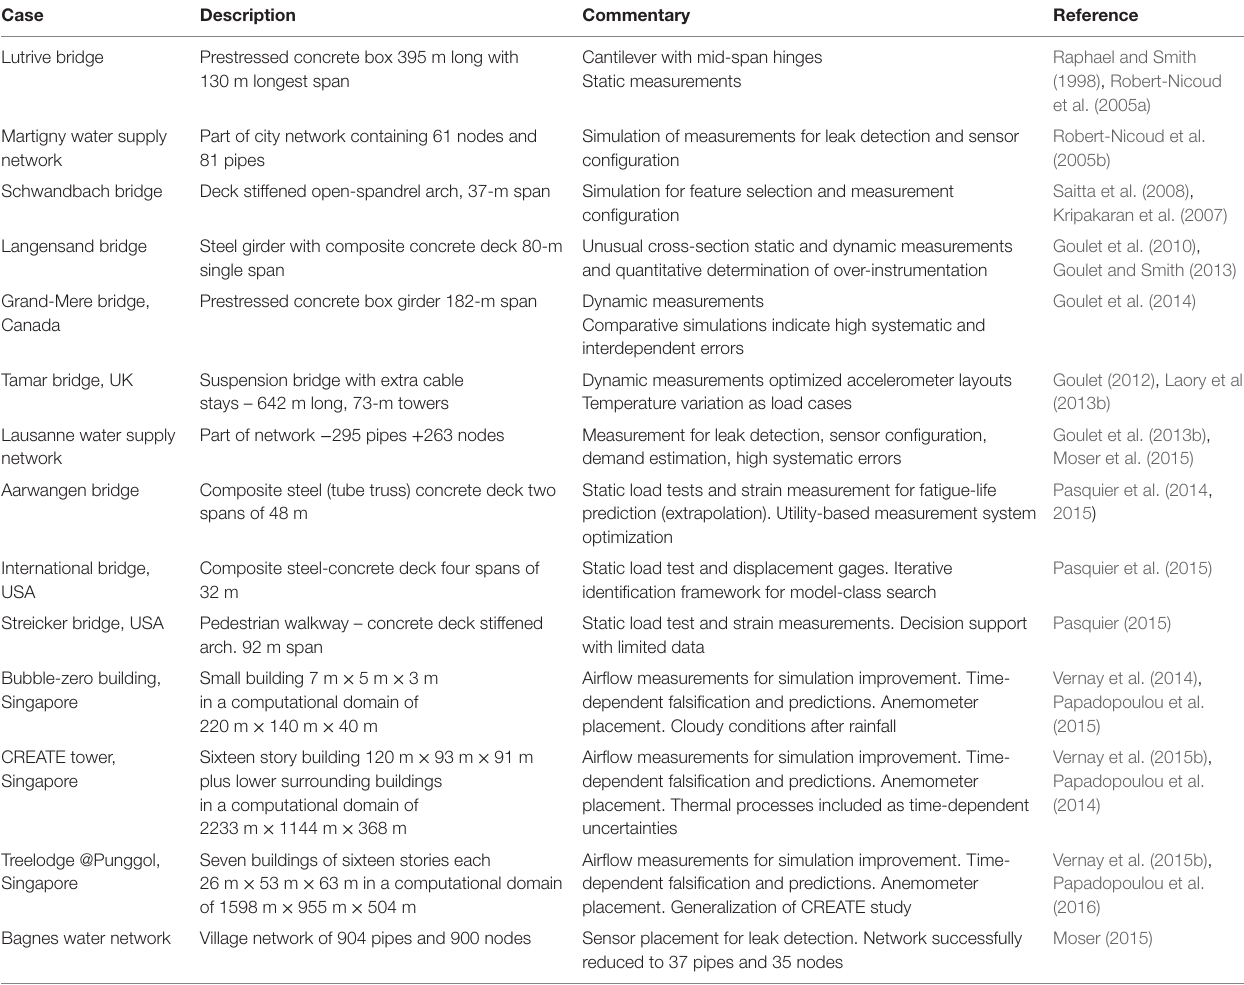
TABLe 1 | Fourteen full-scale case studies that were used to evaluate test and improve multiple-model structural identification and later, probabilistic model